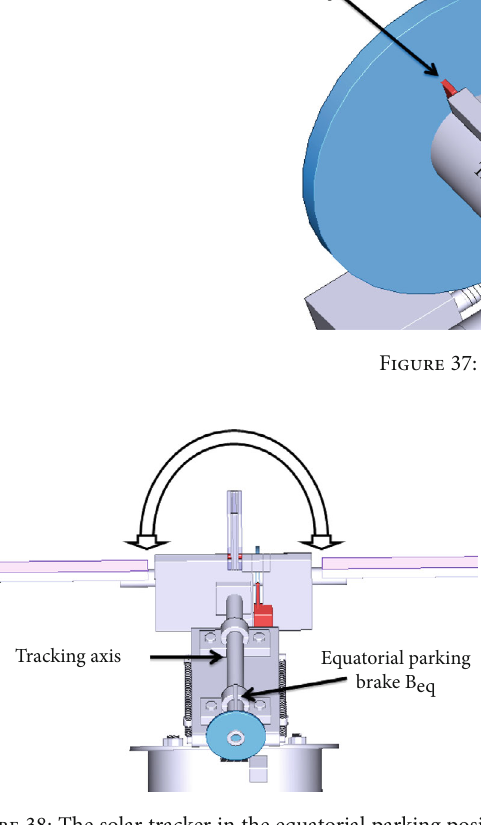
Figure 38: The solar tracker in the equatorial parking position.